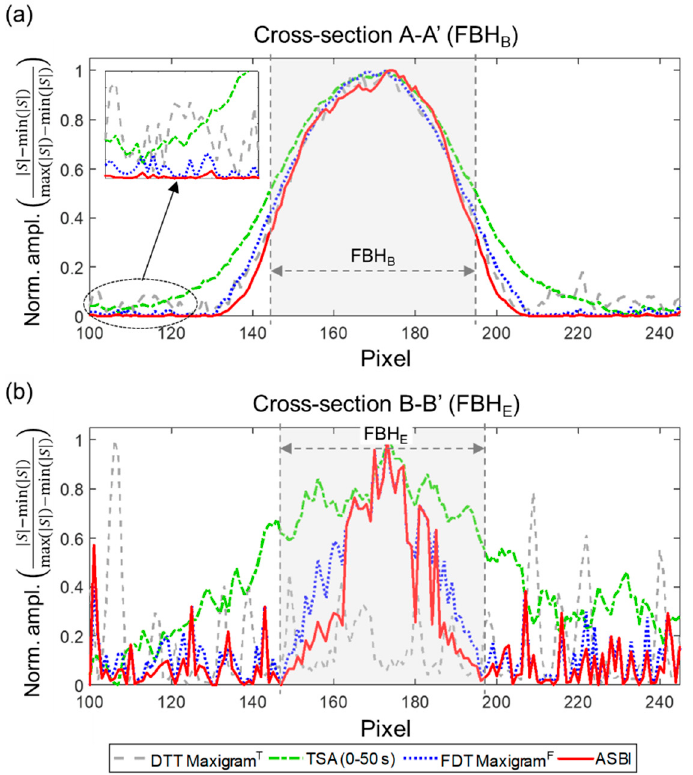
Figure 6. Normalized cross-sections ( a ) A-A’ (FBH B ); and ( b ) B-B’ (FBH E ) for the post-processed results by DTT maxigram T , TSA (0–50 s), FDT maxigram F , and ASBI. See Figure 5a for the location of both cross-sections.